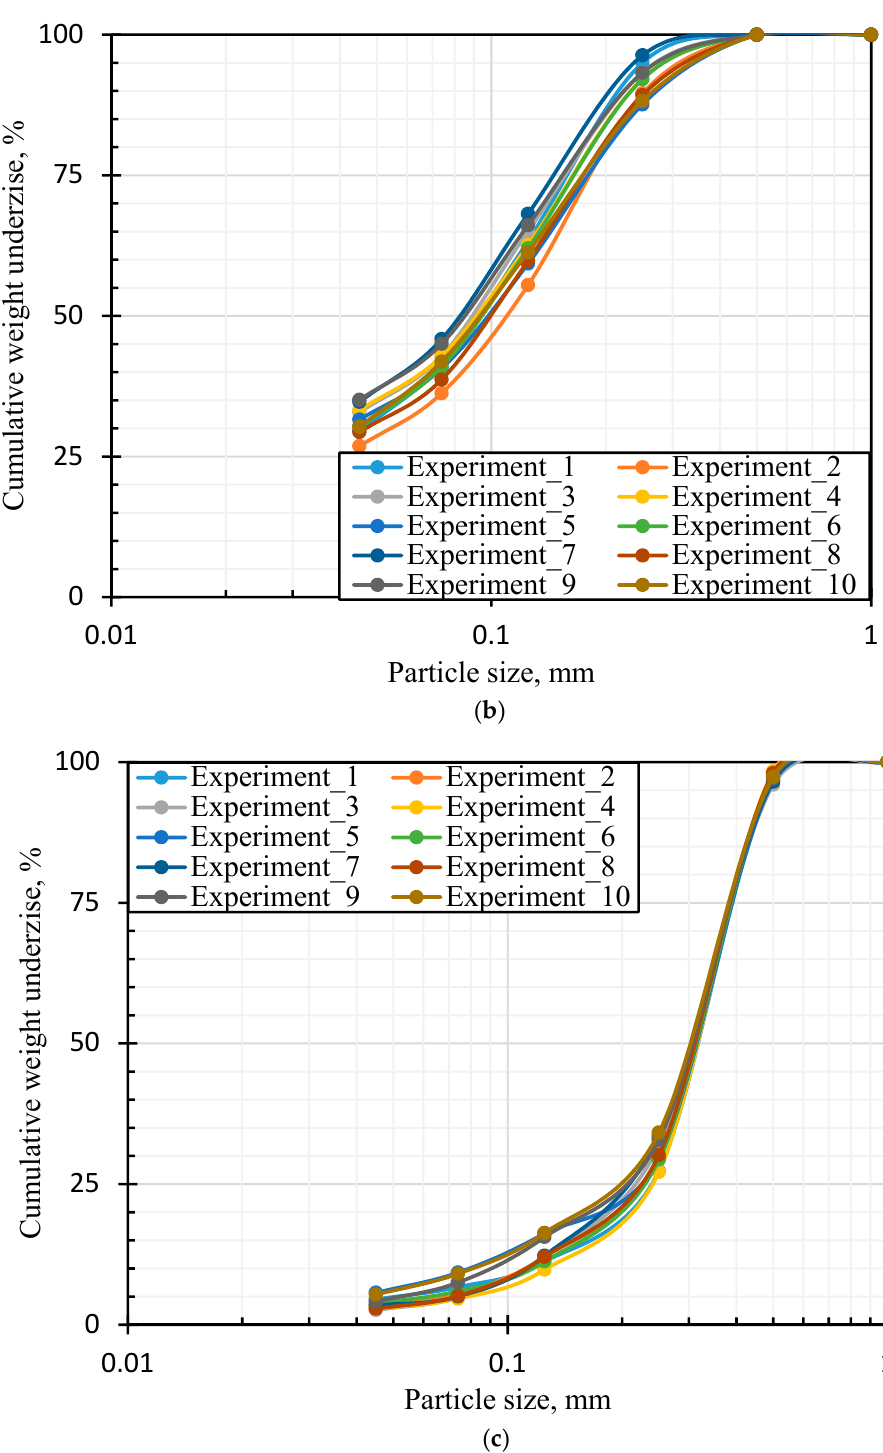
Figure 3. Size distribution for TPHS ( a ) overflow, ( b ) screen underflow, and ( c ) underflow. The solid recovery and water recovery of each product stream for TPHS are exhibited in Table 3, which were estimated using the formulas above (Equations (1)–(4)) and the definition, respectively. It is evident that the solid recovery in both underflow and screen underflow was more than that in overflow, which demonstrates that fewer particles discharged via overflow. In addition, the water recovery in underflow was less than that in overflow and screen underflow, which indicates that less water (i.e., lower bypass flow fraction [31]) flowed through underflow stream. In Figure 4, the absent “fish ‐ hook” can be observed distinctly in all corrected partition curves (plotted by Equations (5) and (6)) of TPHS, which leads to the fewer fines sent to underflow and the increasing device performance. This result can be ascribed to the presence of cylindrical screen that altered the size distribution in each product stream [18]. Both the above size distribution and the corrected partition curves of TPHS shows the similar trends to the literature [18], which also verifies the reasonable results in this work. Table 3. Solid recovery of each product stream and water recovery of underflow. Experiment Number